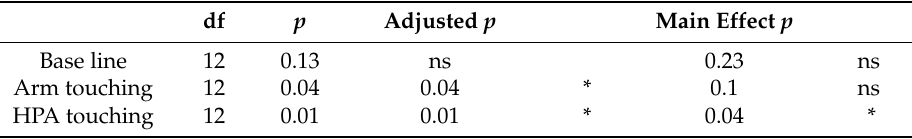
Table 8. The result of the multiple comparison of RSA of the healthy